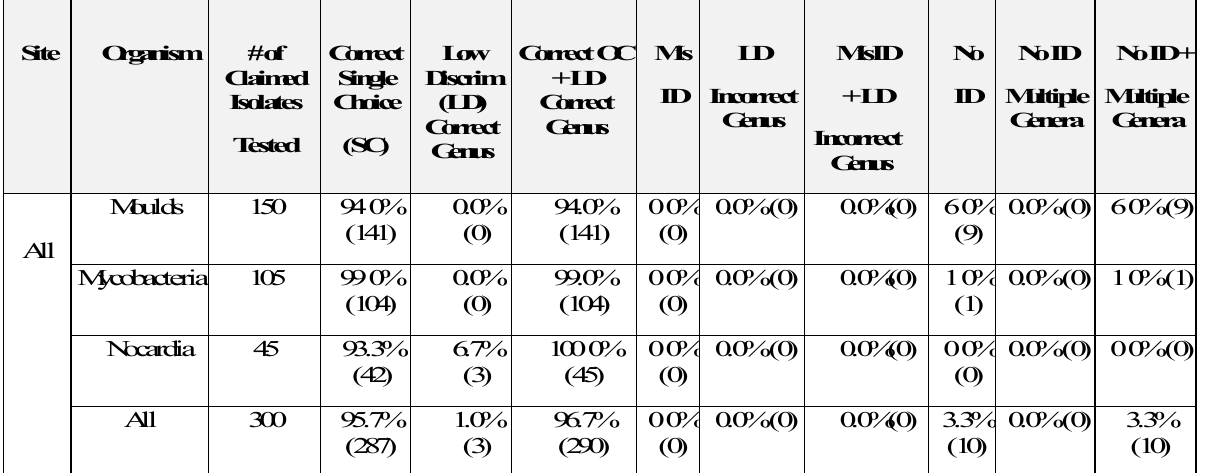
TABLE 11: Challenge Study Results with VITEK MS V3.0 Knowledge